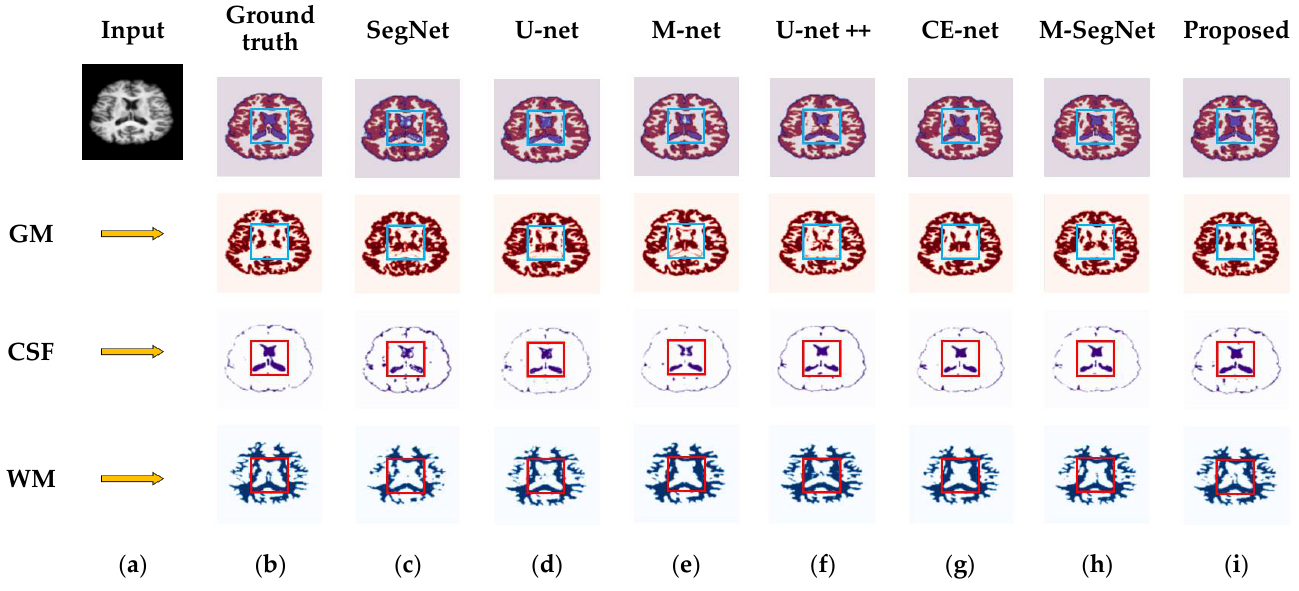
Figure 7. Qualitative comparison for GM, CSF, and WM using the proposed method and existing methods for the IBSR dataset. From left to right: ( a ) original input image; ( b ) ground-truth map; ( c ) segmentation results obtained by SegNet; ( d ) segmentation results obtained by U-net; ( e ) segmen- tation results obtained by M-net; ( f ) segmentation results obtained by U-net++; ( g ) segmentation results obtained by CE-Net; ( h ) segmentation results obtained by M-SegNet; ( i ) segmentation results obtained of the proposed SM-SegNet.